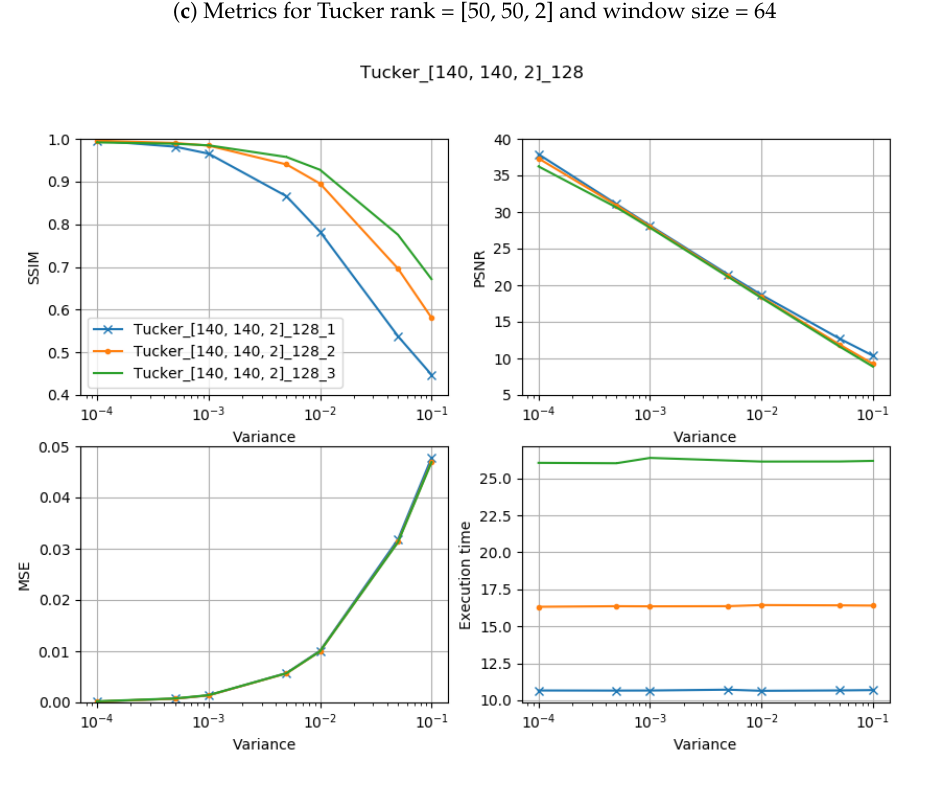
Figure 5. Method performance measured with MSE and SSIM metrics in respect to the noise variance σ 2 as defined in Equation